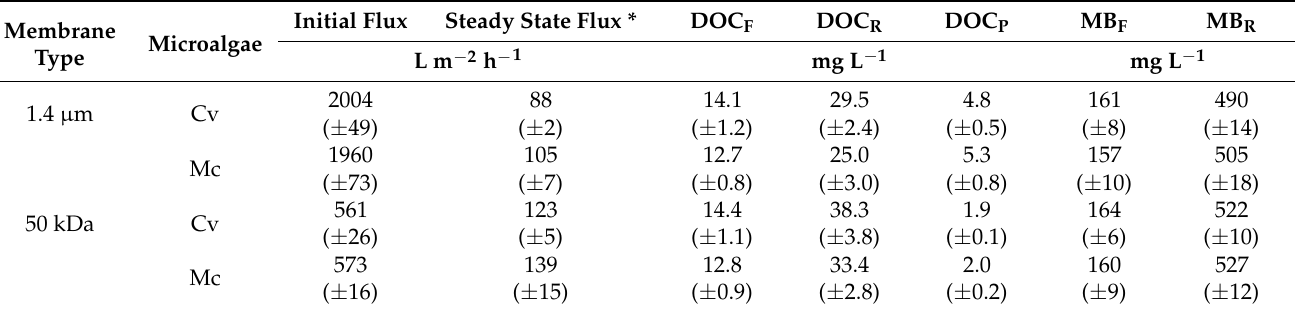
Table 1. Initial and steady-state flux, concentration of dissolved organic carbon in the feed (DOC F ), retentate (DOC R ) and permeate (DOC P ), microalgae biomass in feed (MB F ) and retentate (MB R ); ( ± standard deviation; Cv– C. vulgaris ; Mc– M. contortum ).